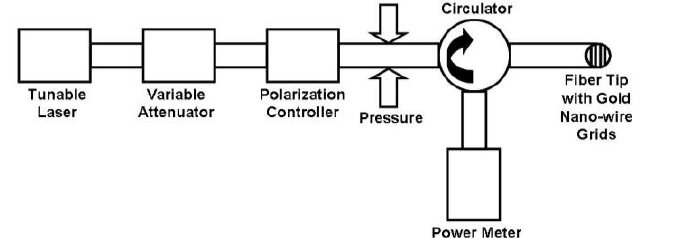
Figure 3. Experimental setup to demonstrate the NWGFP and pressure